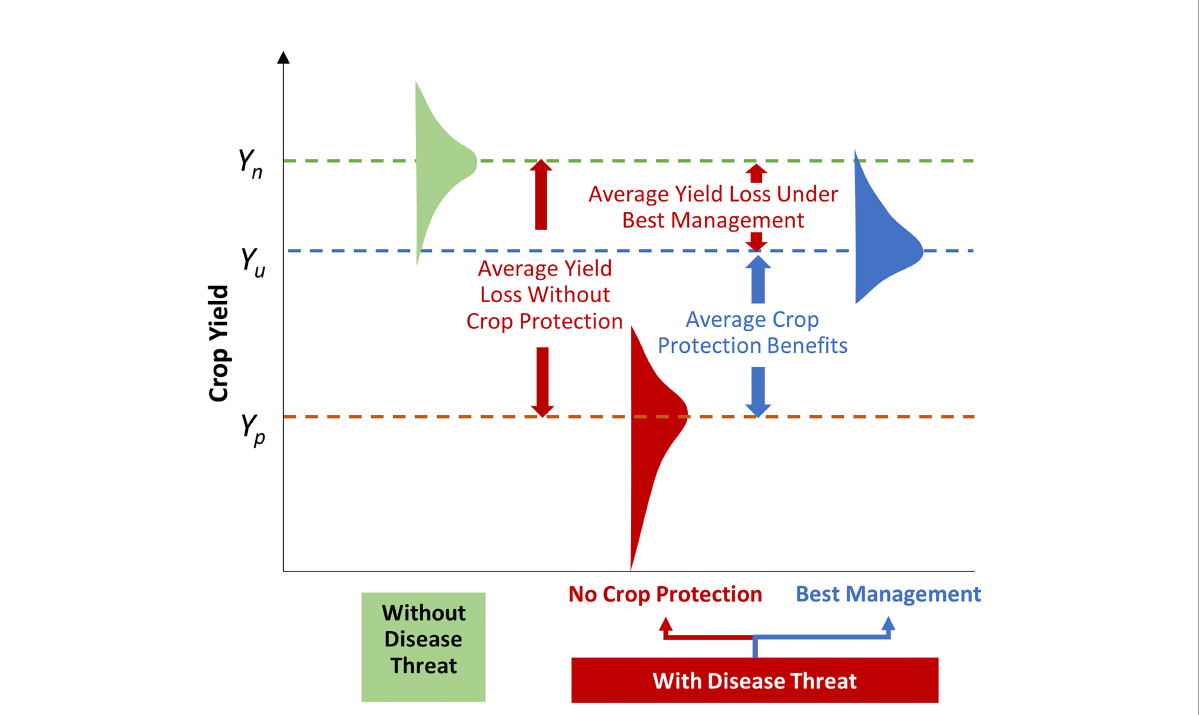
FIGURE 2 Raising crop productivity and derisking farmers ’ yields. The green distribution re fl ects variation in ( fi eld-scale) crop yields around an average yield, Y n , that is free of any pest threats. Here the distribution in yields represents the effects of season-to-season variation in local weather. Y p represents the average yield for the same crop in the same agroecology, but now yields vary in response to both local weather and pests. This red-shaded distribution has a long downside tail stretching to zero to indicate low probability but nonetheless severe (and in rare cases, total) loss events arising from a pest infestation. The difference in yields ( Y p – Y n ) represents the losses, on average , attributable to pest threats. Through deployment of best pest management and mitigation practices, the yield losses due to crop pests can be restored, and if fully effective , would raise yields (or conversely reduce unit costs of production), on average, from Y p to Y n . A cost-effective approach to dealing with crop pests is unlikely to fully restore yields (and thus household food and nutrition access, and perhaps farm incomes) on average , or eliminate yield risk entirely. Rather it would involve protecting yields and reducing risks up to the point that the marginal (or incremental) bene fi ts equals the marginal costs of ameliorating the crop damage consequences of pests. This is indicated by the shift from the red to blue yield distribution pro fi les, where average yields are increased from Y p to Y u (the average yield under the no-disease-threat regime), that is largely, but not fully, restored and the dispersion in yields around the average is reduced. This reduction in risk is visually represented in terms of the more peaked yield distribution (blue) when farmers use pest-reducing innovations versus when they do not (red), such that reducing the variability in yields de-risks cropping for farmers and others in the supply